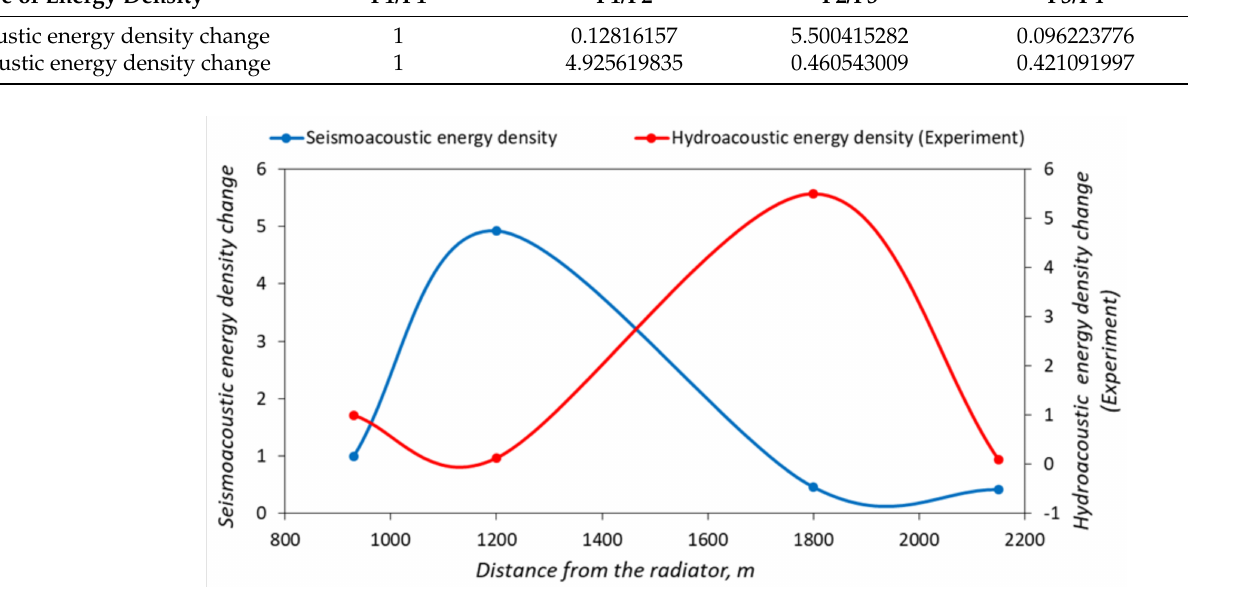
Figure 5. Changes in hydroacoustic and seismoacoustic energy densities from point to